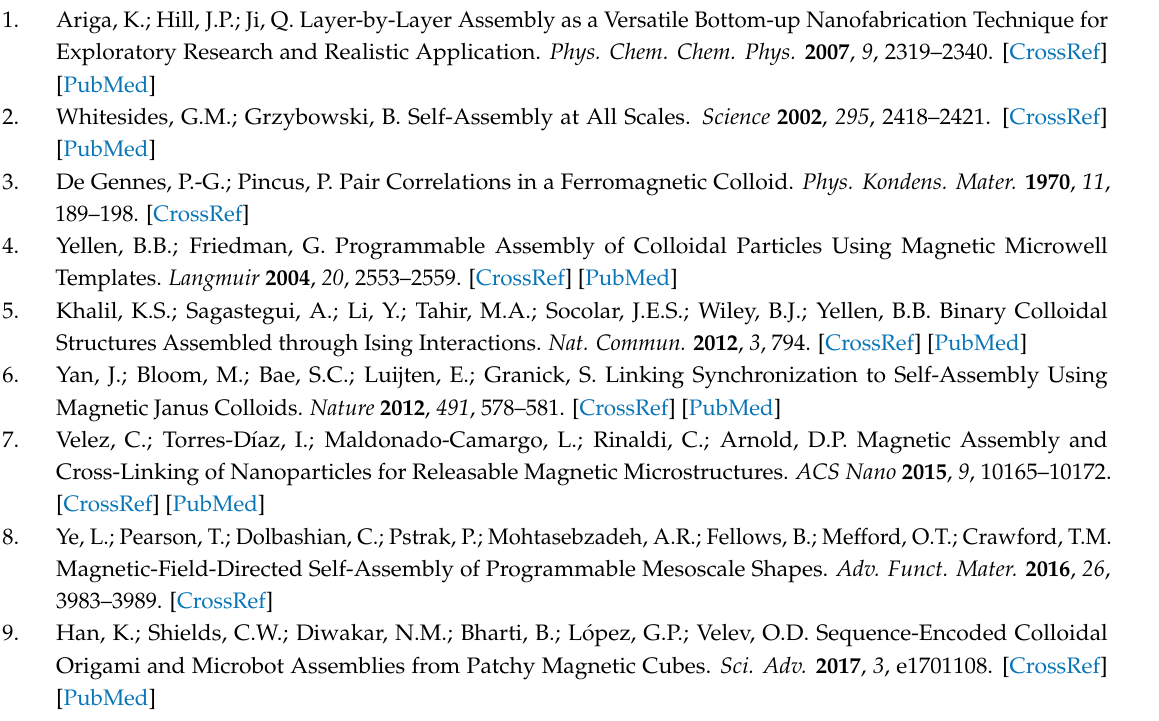
Figure S1: The average chain length as a function of time under homogeneous magnetic fields at 5 mT. Starting conditions of θ A = 0 ◦ and s x = 26 µ m, Figure S2: Details on phase diagram calculations, Figure S3: Evolution of the principal angle of the cuboids with the applied magnetic field from starting conditions of θ A = 22 ◦ and s x =13 µ m. Acknowledgments: Joe W. Tavacoli was funded by the Fondation Pierre Gilles de Gennes pour la recherche